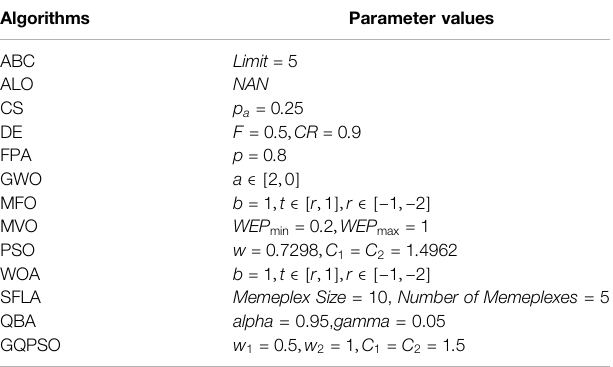
TABLE 1 | Parameter value setting for the comparison algorithms.